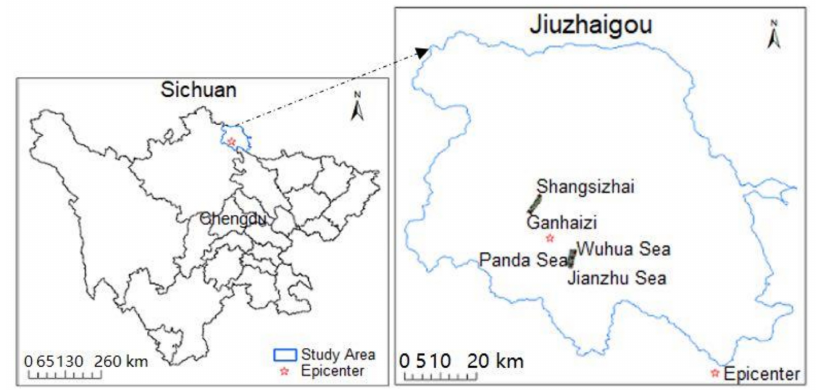
Figure 7. Study area